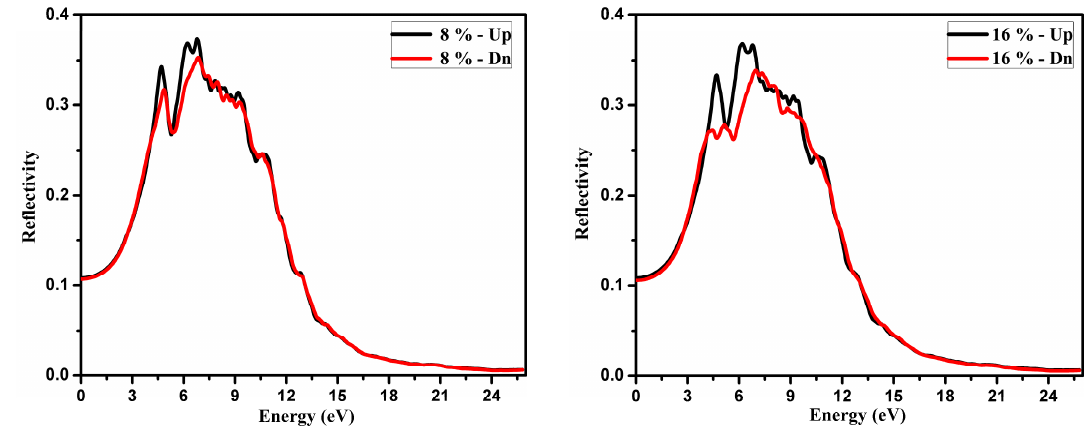
Figure 9. Calculated reflectivity (long solid curve-black color for up) and (long solid curve-red color for down) spectra of Mn x Zn 1 − x Te (x = 8% and 16%).